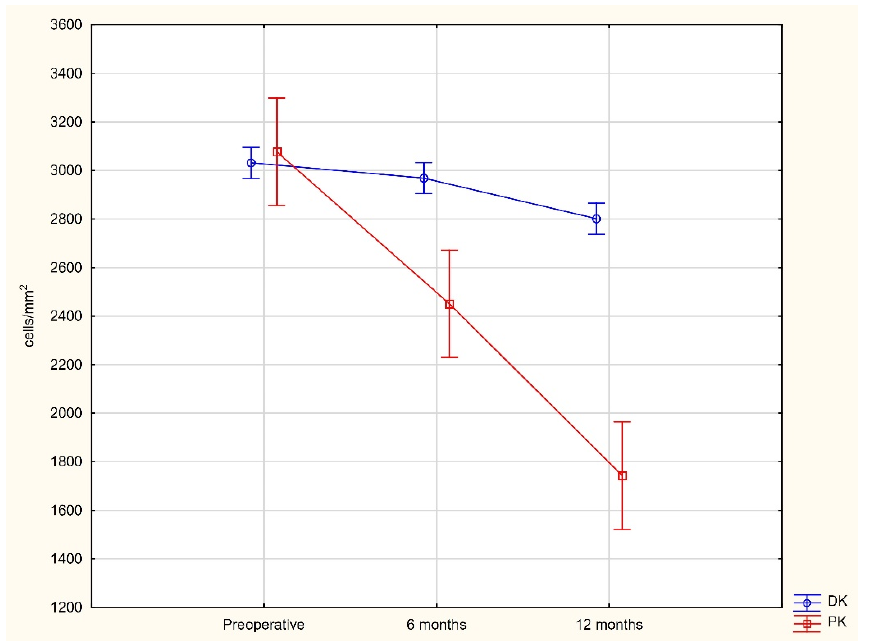
Figure 2. Changes in the number of endothelial cells in DK and PK patients during 12 months of observation ( p < 0.05) .